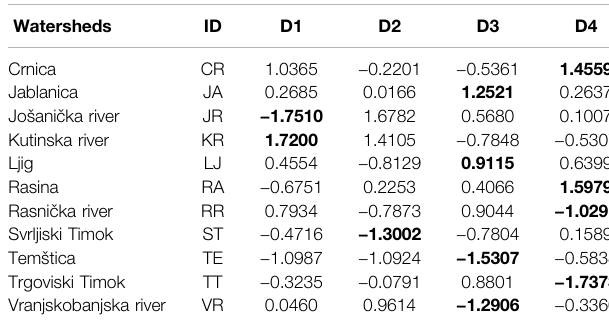
TABLE 10 | Factor scores after Varimax rotation for